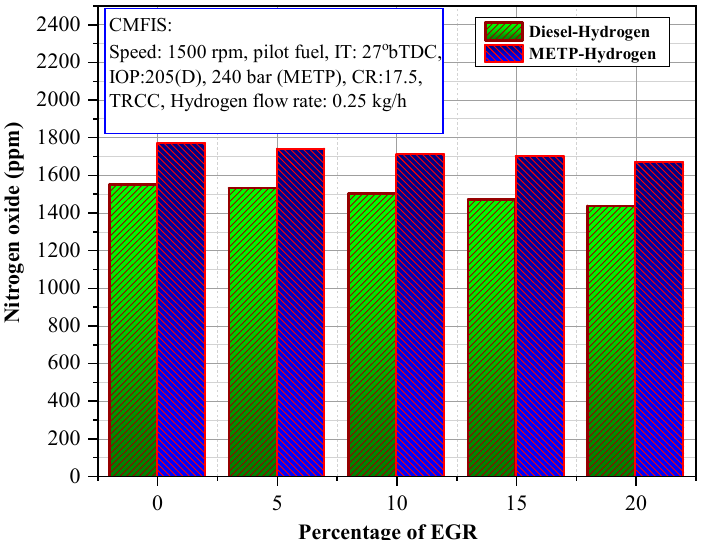
Figure 9. Influence of EGR on the NO X with induction method.